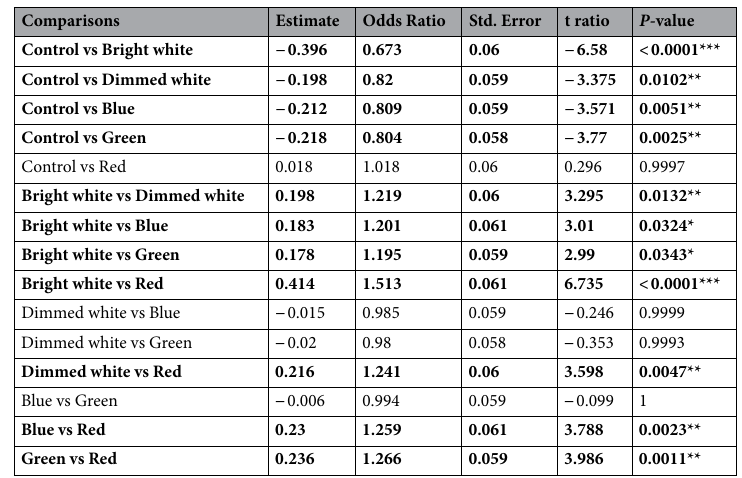
Table 1. Summary of the results of post-hoc pairwise tests of the comparison of differences in bird counts between experimental pairs (‘light-on’, ‘light-off’) and control pairs (‘light-off’, ‘light-off’). Negative estimates indicate that bird numbers decreased in the presence of illumination compared to control periods. Estimates taken from the GAM (spectra experiment) show log-transformed differences in counted birds. For example, bright white caused a (0.67 – 1) * 100% = -33% decrease in counted birds when we turned on the light compared to control pair (‘light-off’, ‘light-off’). Significant results are marked in bold. *** P < 0.001; ** P < 0.01; * P < 0.05.